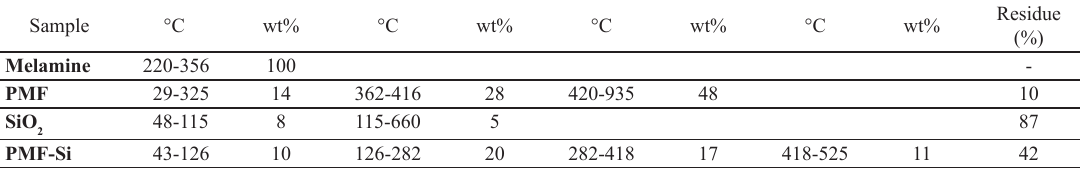
, and (d) PMF-Si composite. 2 , and PMF-Si composite samples. The weight 2